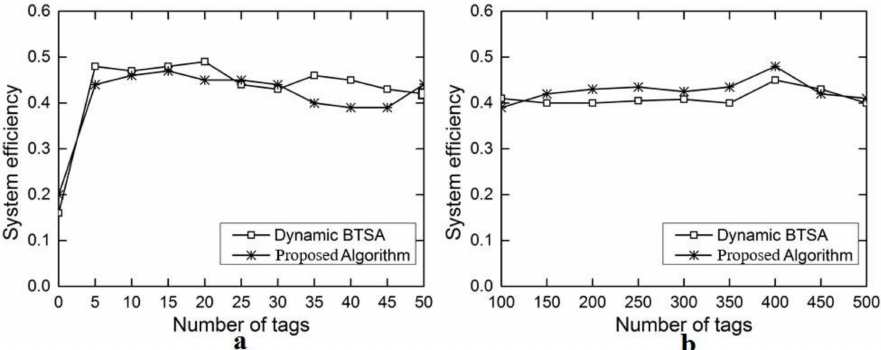
Figure 10. Comparison on system efficiency for identifying all tags between DAF-OS and DBTSA.